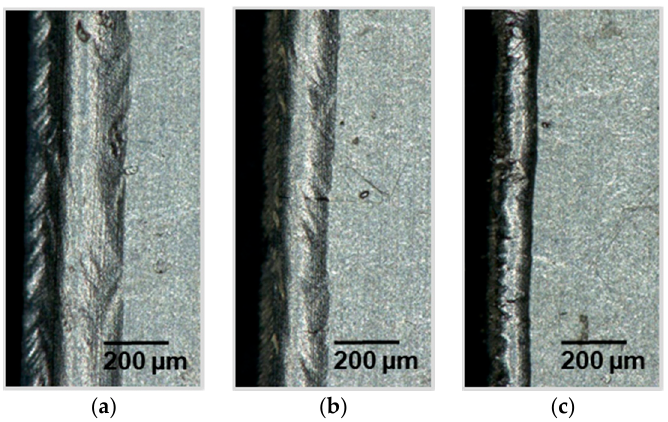
Figure 5. Light microscope sections of a laser cut lithium sheet: 72.8 W, 490 kHz, 240 ns; ( a ) 75 mm/s, PO 99.83%; ( b ) 100 mm/s, PO 99.77%; ( c ) 150 mm/s, PO 99.66%.